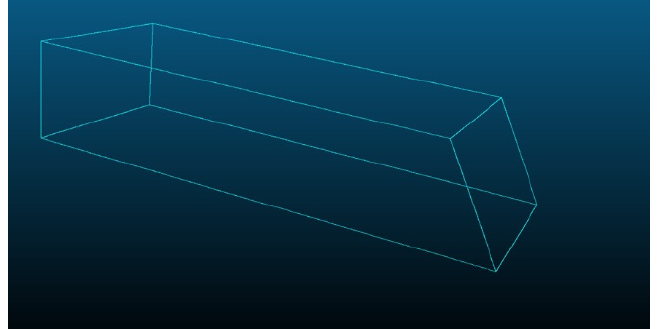
Figure 12. Example of detecting four vertices of a door. Figure 13. A method to match the plane between two models. First, the four vertices ( 𝑀 (cid:2869) , 𝑀 (cid:2870) , 𝑀 (cid:2871) , 𝑀 (cid:2872) ) on the 3D hexahedron model and the four vertices ( 𝑄′ (cid:2869) , 𝑄′ (cid:2870) , 𝑄′ (cid:2871) , 𝑄′ (cid:2872) ) on the cargo box plane are set as points of convergence. ( 𝑄′ (cid:2873) , 𝑀 (cid:2873) ) is a virtual point of convergence used to eliminate the symmetry ambiguity. The cargo box has a rectangular parallelepiped form, and its calculation is subject to errors. The virtual point of convergence is determined from the cross-product of each point cloud unit vector, |𝐴| and |𝐵|(cid:3554) , which become direction vectors of identical magnitude. When the five points of convergence are defined, the 3D transformation matrix, 𝑇 (cid:3014)→(cid:3004) , is ob- tained with its error minimized, as in the following equation. Figure 14 shows the result of matching the cargo box to the hexahedron model using the transformation matrix. The figure shows errors, but a match was made based on the cargo box plane.